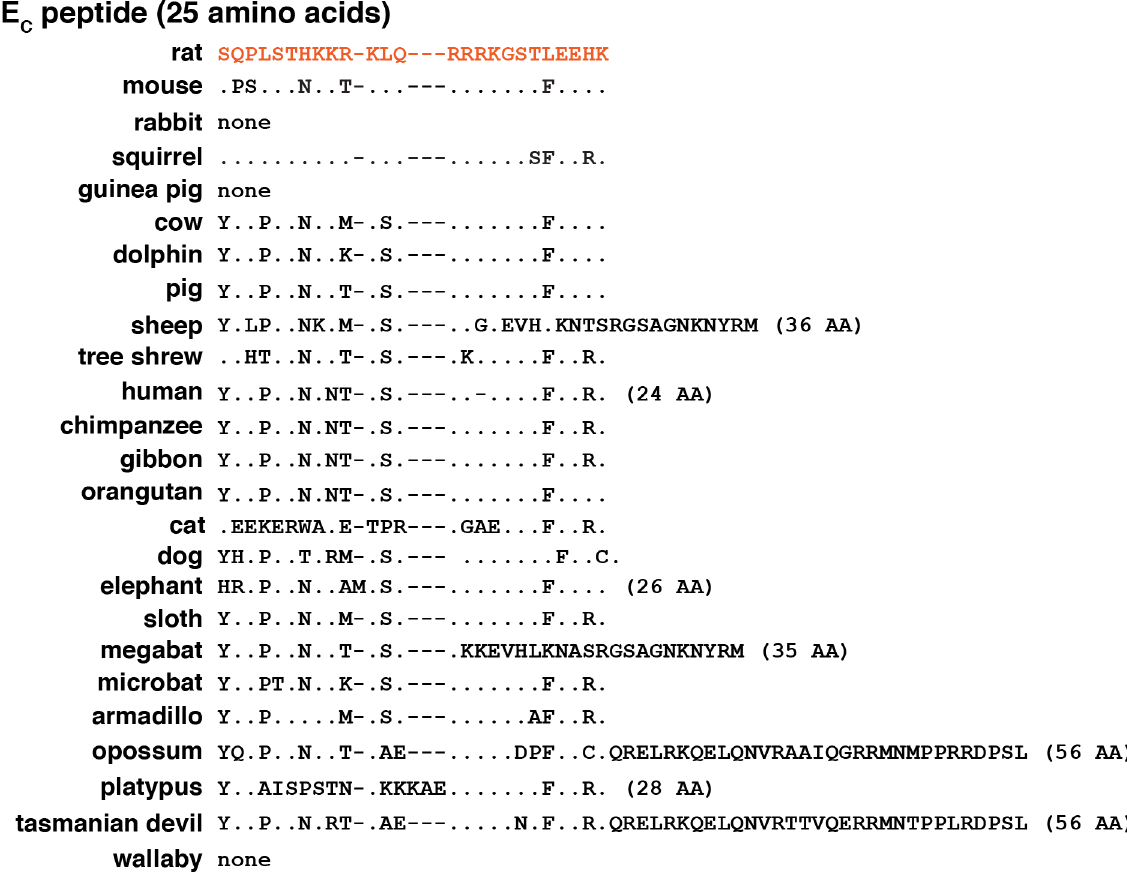
Fig 5. Alignments of mammalian IGF1 E C peptides. Depictedare amino acid sequencesof COOH-terminal E C peptides. Identities with rat IGF1 are indicatedby dots and a dash depicts no residue. The number of amino acids in each E C segment is listed in parenthesis. The color of rat IGF1 amino acids corresponds with the map in Fig